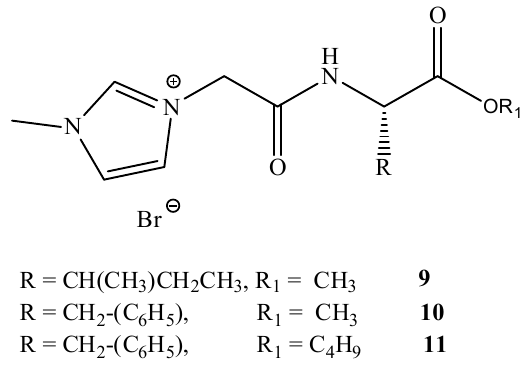
Figure 5. General structures of amino acid derived ILs.